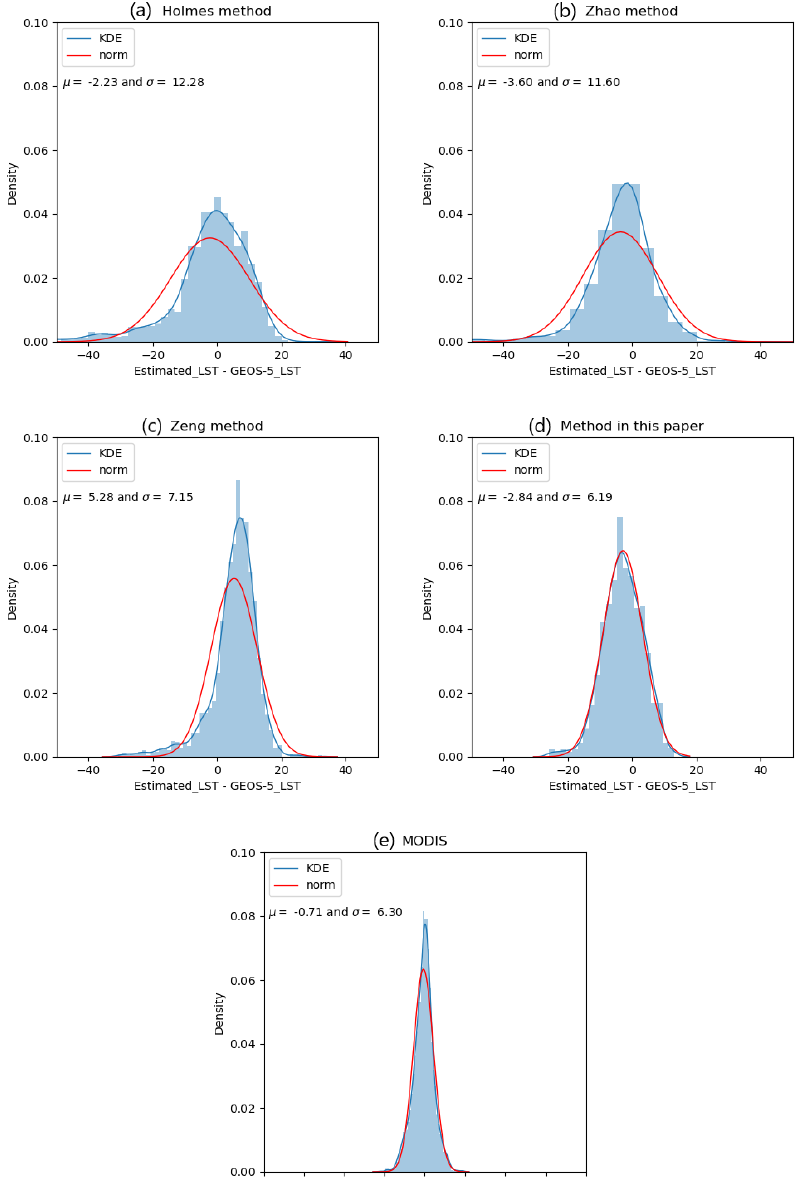
Figure 9. Probability density histogram of the difference between the estimated LST/MODIS LST and GEOS-5 LST. ( a ) Holmes method. ( b ) Zhao method. ( c ) Zeng method. ( d ) Method in this paper. ( e ) MODIS LST. In blue is the kernel density estimate (KDE); the red line represents the fitting standard normal distribution (norm).